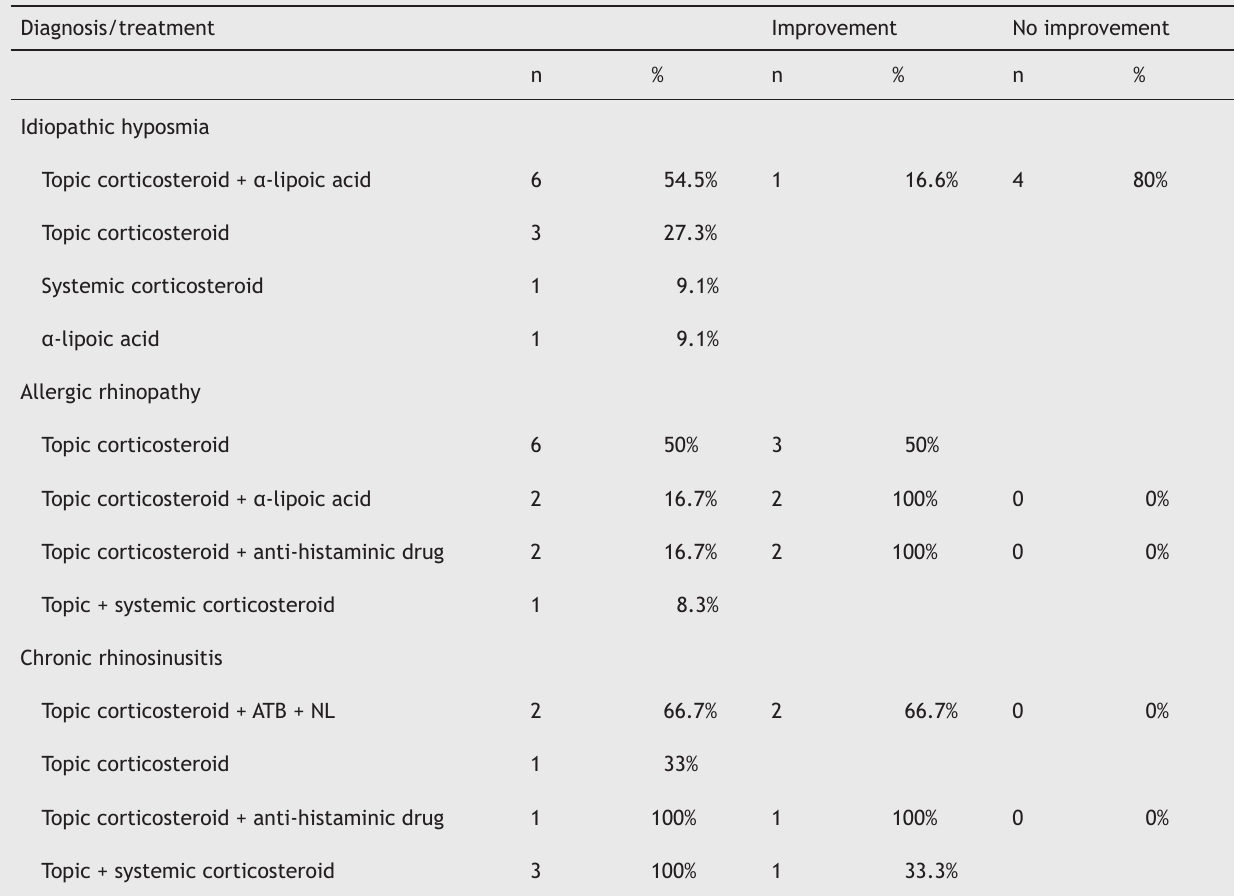
Table 6 Type of treatment stratified by diagnosis.